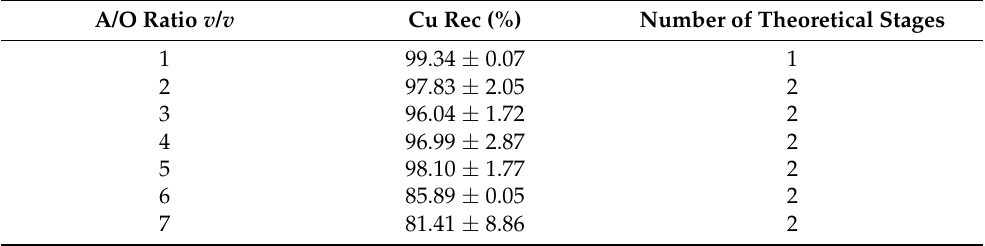
Table 3. Cu extraction rate and theoretical stages required for complete extraction at different